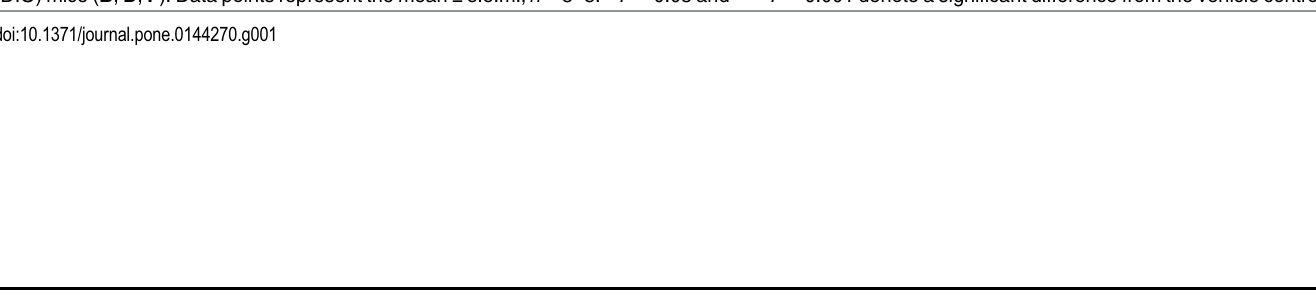
PLOS ONE | DOI:10.1371/journal.pone.0144270 December 3,